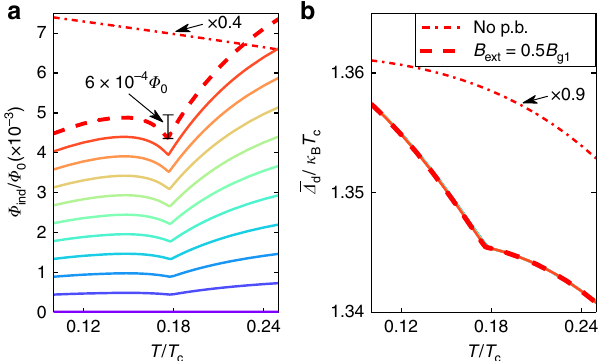
Fig. 5 Magnetic fl ux as a function of temperature. a Temperature dependence of the induced magnetic fl ux, de fi ned in Eq. (5). The solid lines indicate, from bottom to top (colors purple to red), the external fi eld magnitude from B ext = 0 to B ext = 0.5 B g1 in steps of 0.05 B g1 . The line corresponding to zero fi eld lies exactly at zero since there is an equal amount of positive and negative fl uxes induced in this case, see Fig. 2. Panel b shows the area-averaged order parameter magnitude de fi ned in Eq. (6) versus temperature. Results are also shown for a system without pair- breaking edges (dash-dotted line) at B ext = 0.5 B g1 , but scaled with a factor 0.4 and 0.9 in a and b ,